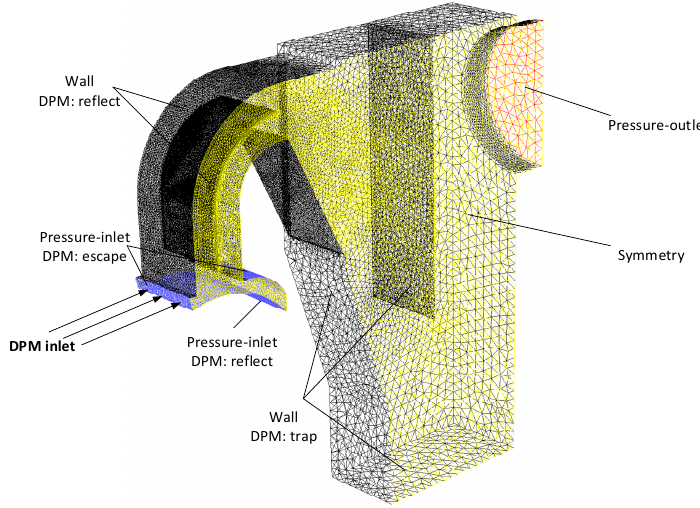
Figure 5. The grid and boundary conditions of the NPPS numerical model.